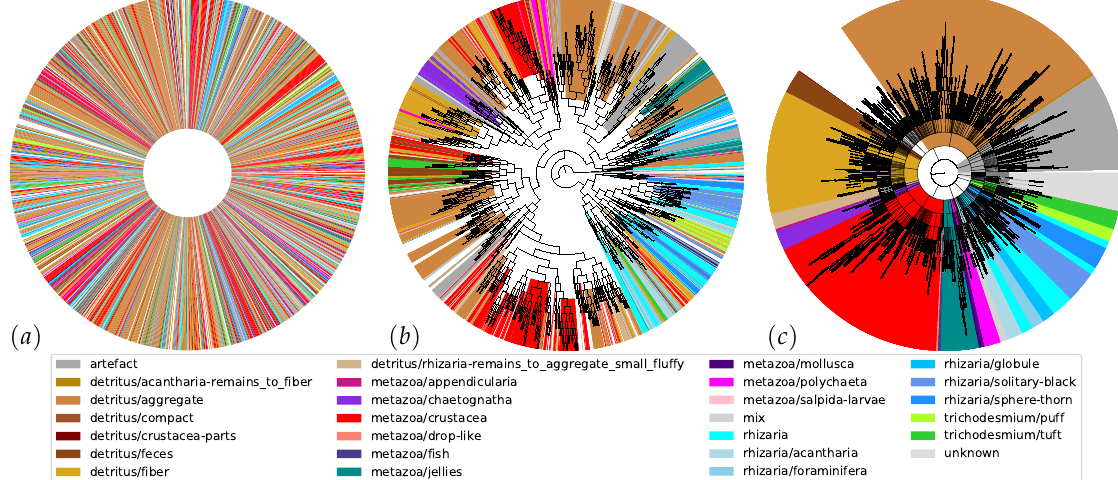
Figure 6. Unordered nodes ( a ), automatic hierarchy ( b ), and revised hierarchy with named branches denoted by bold lines ( c ). Corresponding sections of the three charts are colored alike according to broad supercategories. See the Supplementary Materials for the labels contained in these